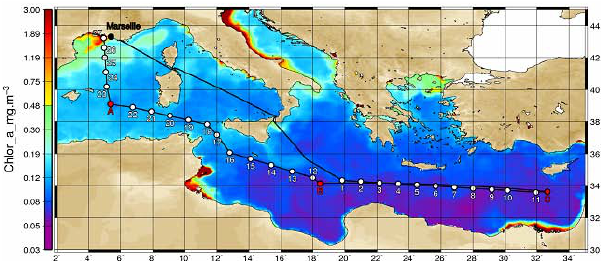
Fig. 1. Transect of the BOUM cruise superimposed on a SeaW- iFS surface Chl- a composite image (June 2008), and location of the fourteen short (numbers) and three LD stations (letters) of the cruise sampled for N 2 fixation during the